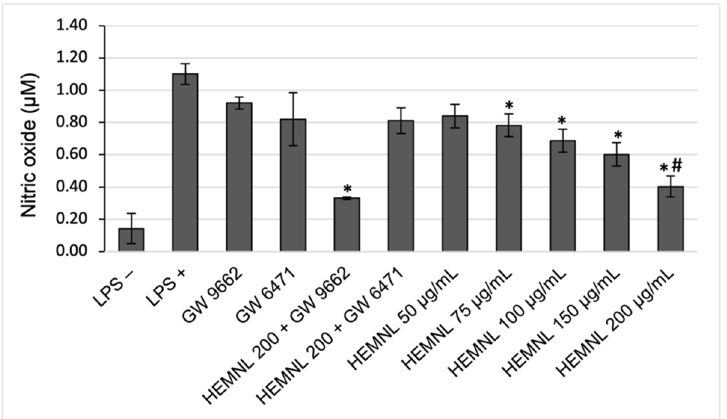
Figure 7. Inhibition of nitric oxide production in lipopolysaccharide (LPS)-stimulated RAW 264.7 cells, evaluated by the Griess method. LPS +: positive control—cells stimulated with LPS and treated with vehicle (DMEM with 2% of ethanol). LPS − : negative control—cells not stimulated with LPS and treated with vehicle. HEMNL: hydroethanolic extract of Morus nigra leaves. Data represent mean ± standard deviation. Statistical analysis was performed by one-way ANOVA and Tukey’s post-test. * p < 0.039 in relation to LPS+; # p = 0.002 in relation to HEMNL 200 + GW